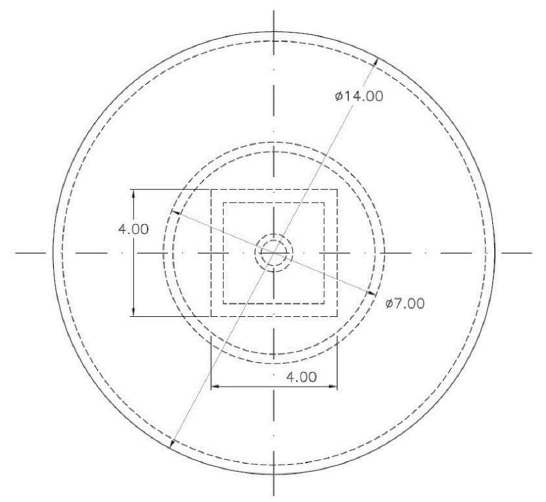
Figure 1. Typical plan view of an elevated water tank.